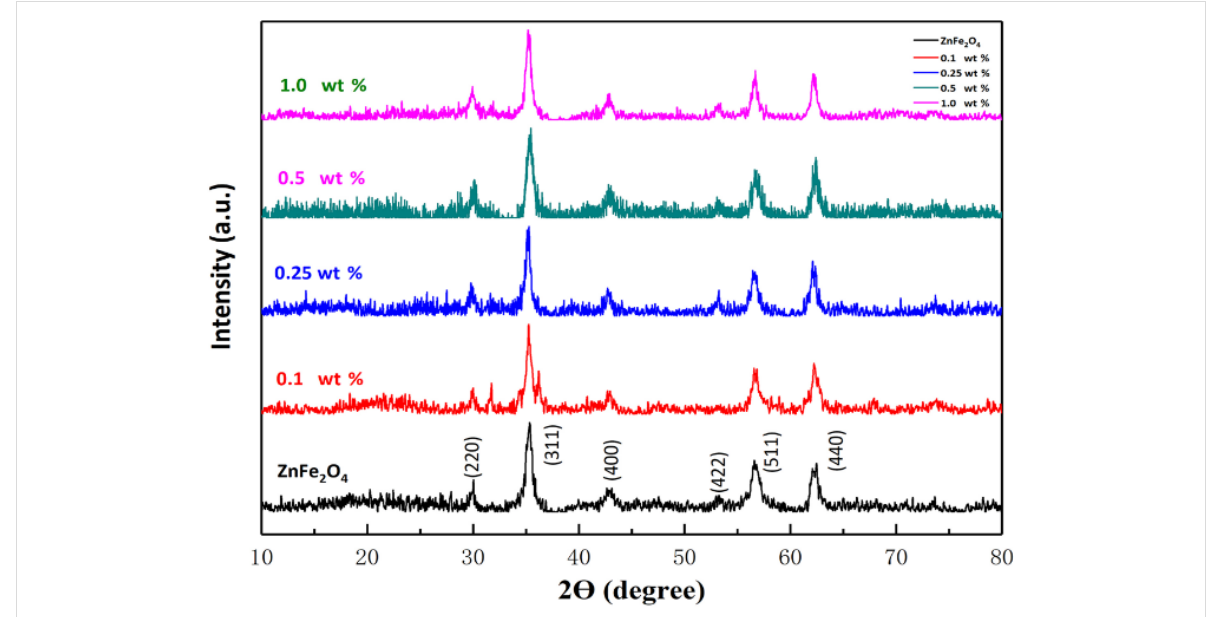
Figure 2: XRD patterns of the synthesized hollow spheres of pure ZnFe 2 O 4 and the different ZnFe 2 O 4 /rGO composites.